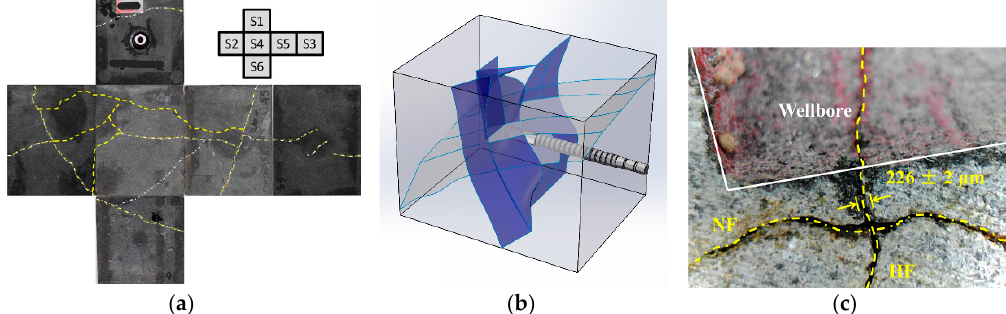
Figure 8. Fracture details of specimen No. 6: ( a ) Distribution on the surface, ( b ) internal reconstruction, and ( c ) microscope image.